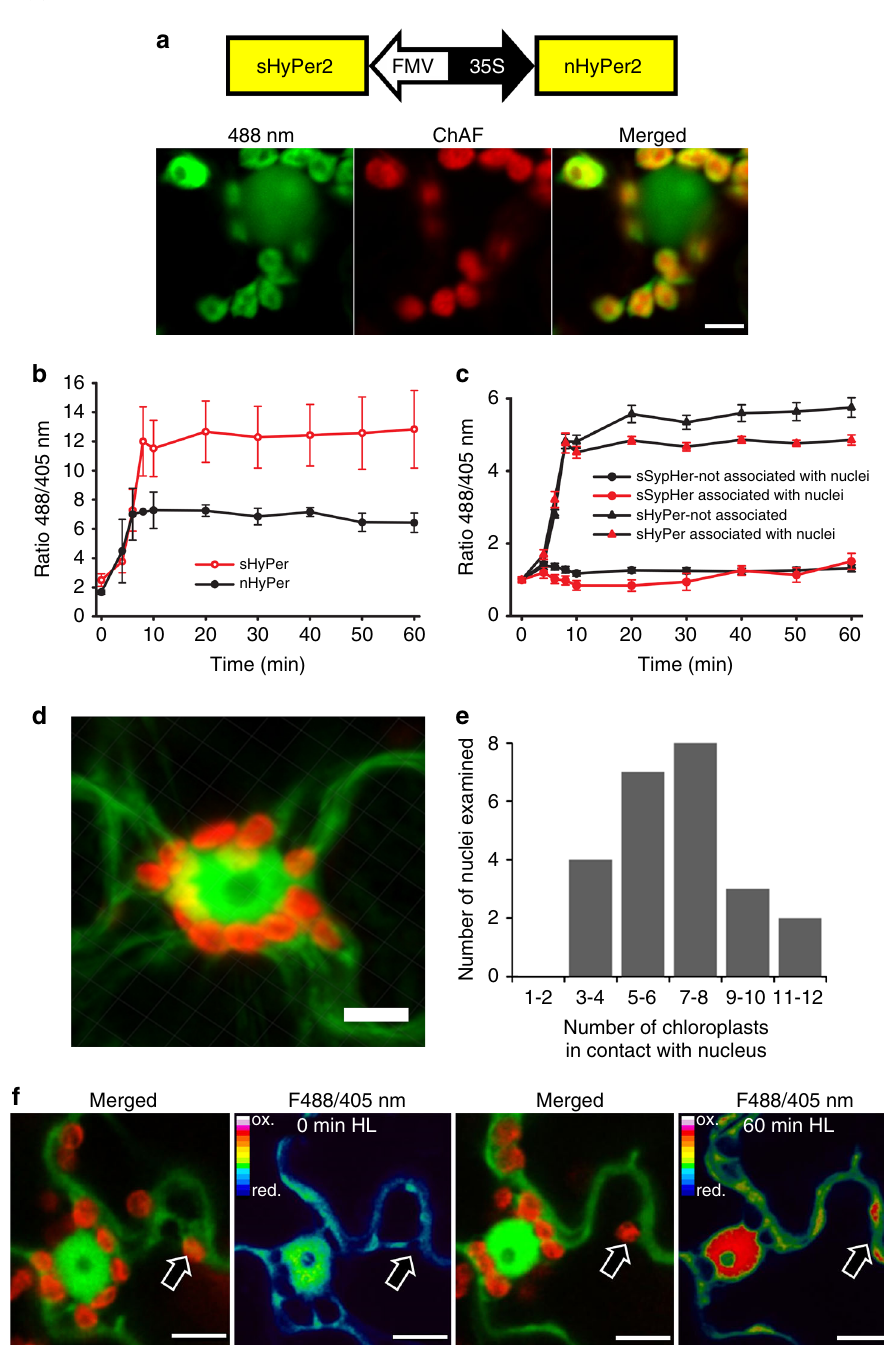
Fig. 3 High light causes coincident oxidation of HyPer2 in chloroplasts and nuclei. a Expression of sHyPer2 and nHyPer2 from a bicistronic construct. The left, middle and right panels show HyPer2 fl uorescence from 480 nm excitation light, chlorophyll auto- fl uorescence (ChAF) and a combined image of the two respectively. Scale bar = 5 µ m. b The effect of exposure to HL over 60 min on the 488/405nm fl uorescence ratio of chloroplasts in epidermal cells expressing sHyPer2 and nHyPer2. The 488/405nm ratio is normalised to 1 at 0 min for each dataset. The data points represent the mean ± SEM values from 40 chloroplasts and 3 nuclei from 3 independent experiments. c From the same experiment as in b but sHyPer2 488/405nm ratios are plotted for individual chloroplasts classi fi ed as appressed or detached from nuclei. d Typical higher magni fi cation of a cell expressing cHyPer2 fl uorescence from 480 nm excitation light showing the position of chloroplasts revealed by chlorophyll auto- fl uorescence. Scale bar = 5 µ m. e The distribution of chloroplasts numbers associated with nuclei. 25 nuclei were examined. f Higher magni fi cation of ChAF and 480/405nm ratio of a cell expressing cHyPer2. Panel shows the merged images of cHyPer2 (F480 nm) with ChAF and the ratio 480/405nm of cHyPer2, in the dark ( fi rst and second images) and after 60 min HL (third and fourth images), respectively. The discrete zones of cytosol-located oxidised HyPer2 (arrowed in right hand panels) detected in the proximity of chloroplasts that are not associated with nuclei. Scale bar = 10 μ